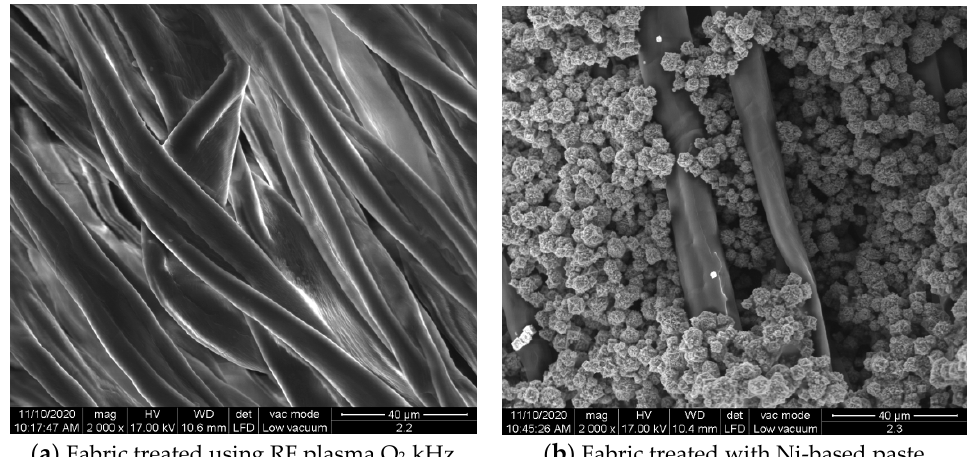
Figure 4. The sample was treated using RF 2 plasma O 2 using kHz generator and power 50 W. ( a ) represents the image of the sample treated using RF plasma O 2 kHz and power 50 W, respective ( b ) represents the sample treated with Ni-based paste.